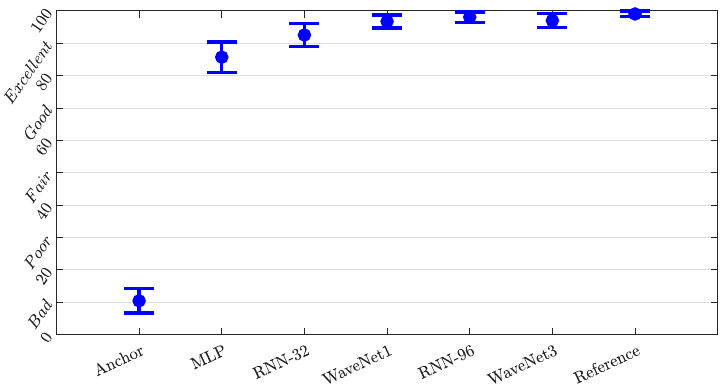
Figure 13. Mean results of MUSHRA test with 95% confidence interval, for models of the Mesa 5:50.